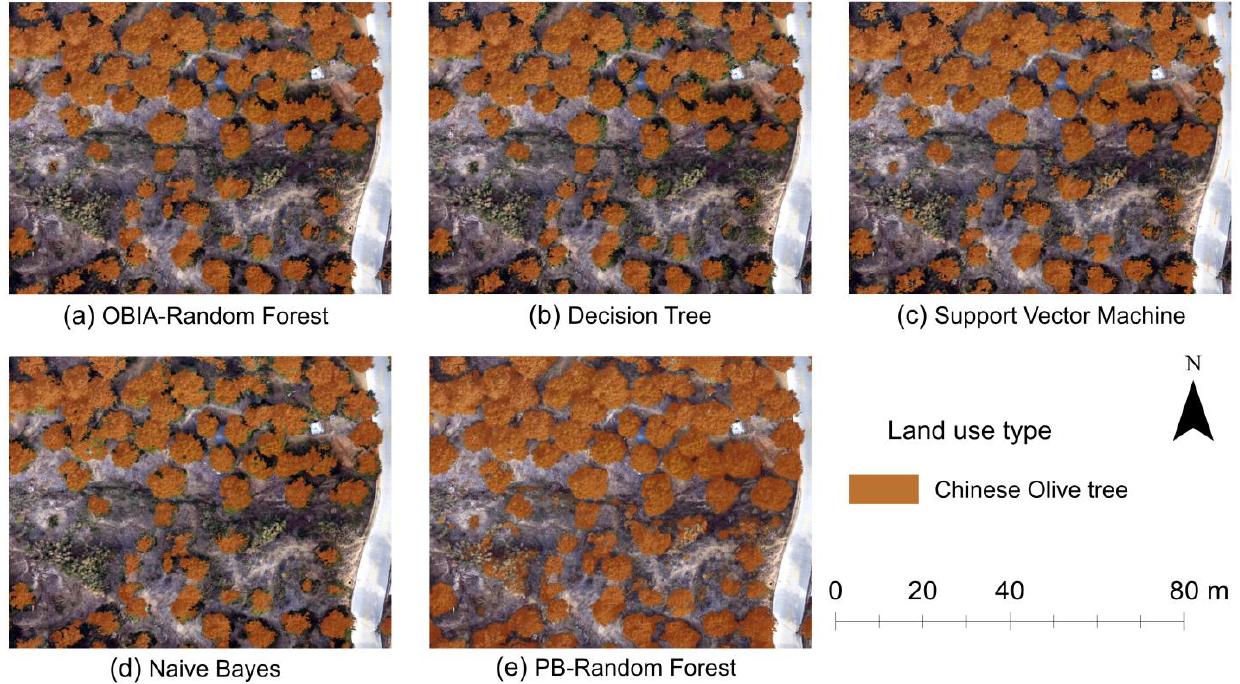
Figure 11. Extraction results of different classification methods under the optimized feature set. OBIA-RF represents the classification result of combining object-based classification methods and the RF algorithm. PB-RF represents the classification result of combining pixel-based classification method and the RF algorithm.